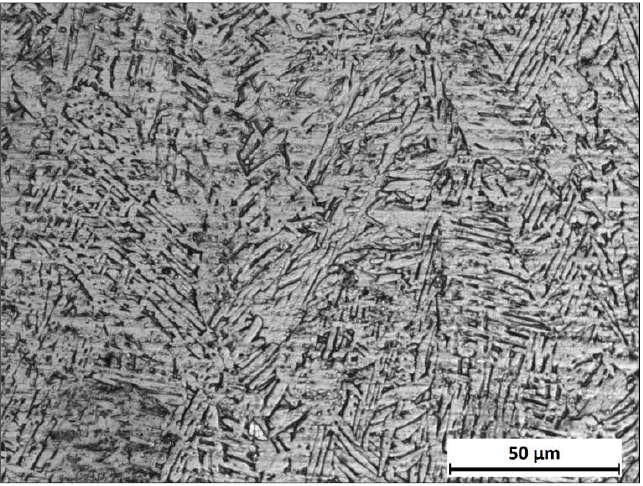
Figure 12. Optical micrographs of specimen B cross section after hot isostatic pressing (HIP).